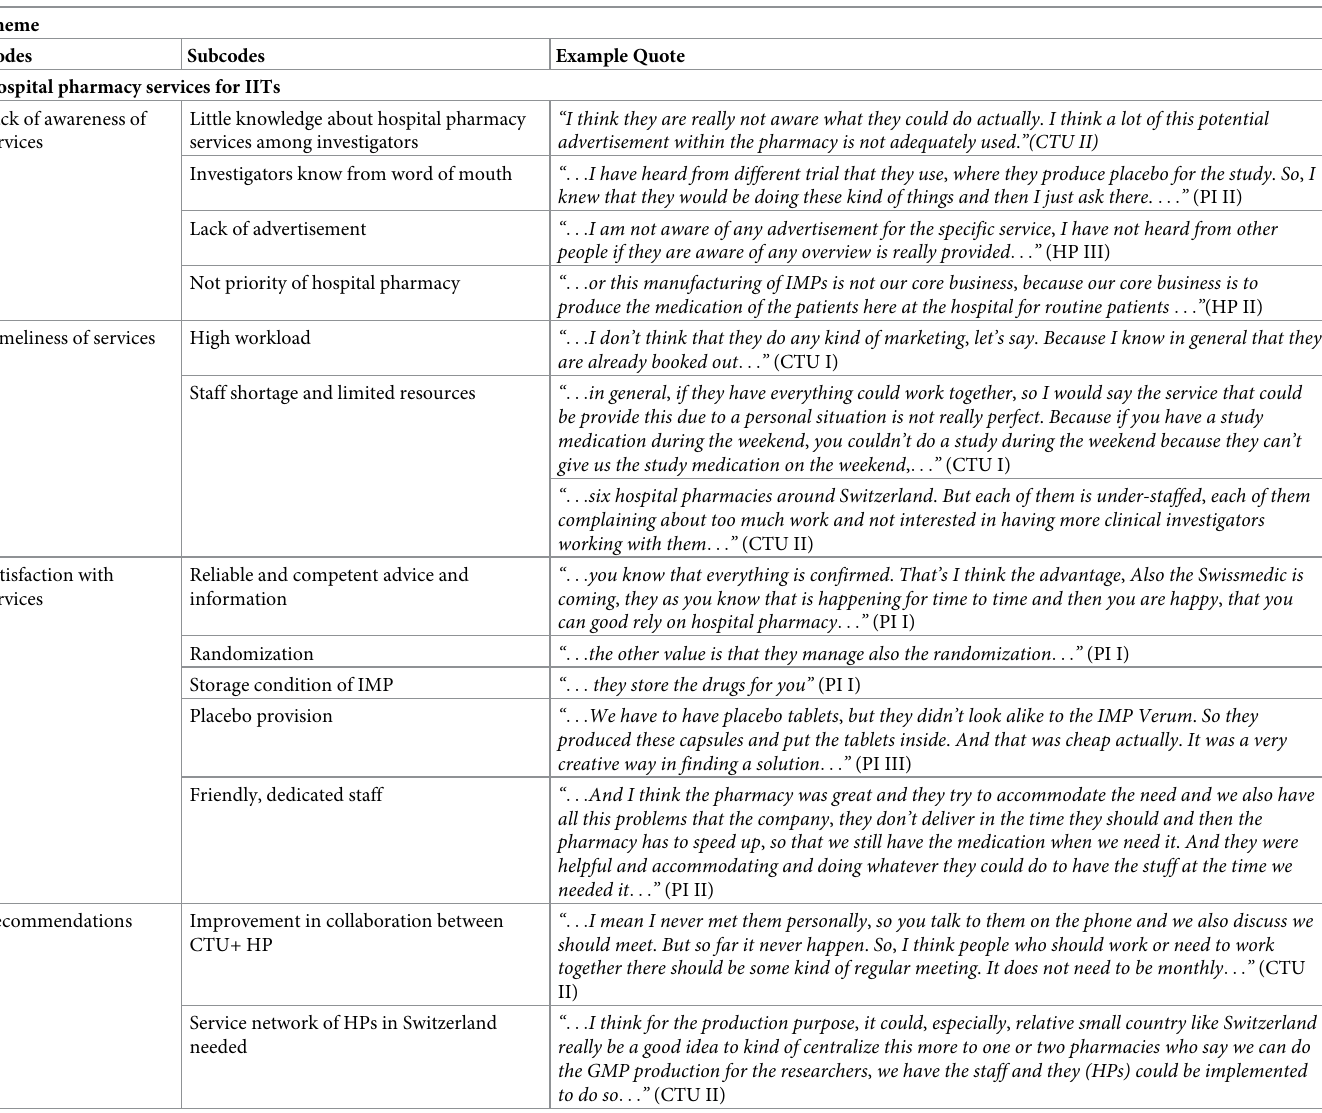
Table 5. Coding scheme regarding IMP services of the hospital